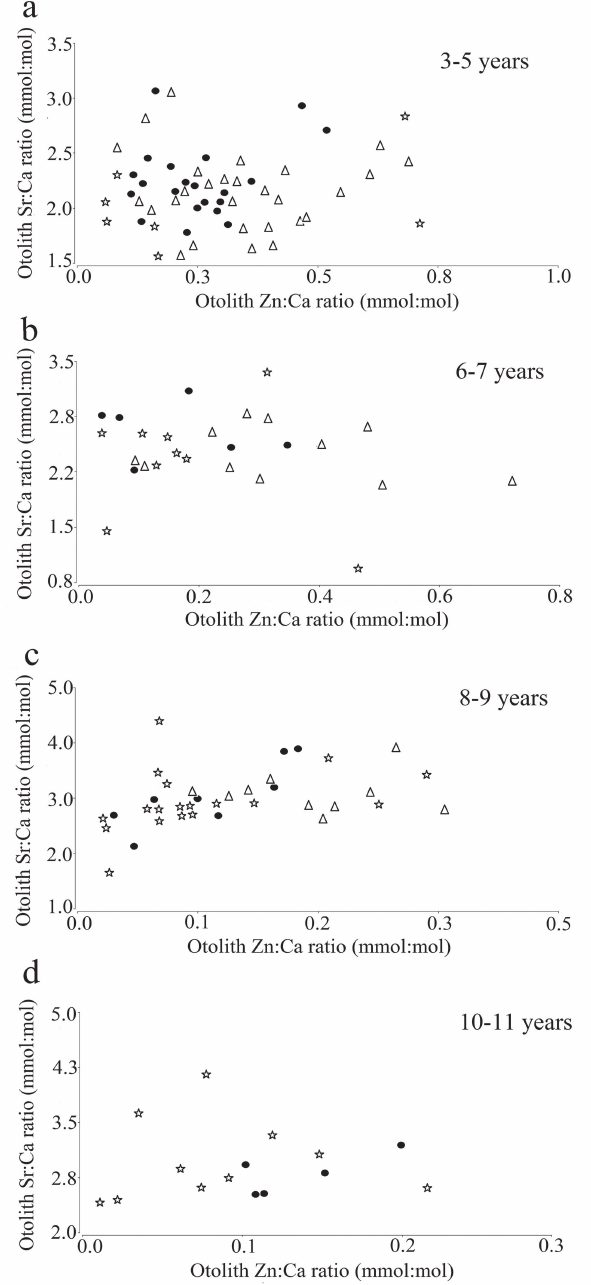
Fig. 3. Relationship between otolith Sr:Ca and Zn:Ca ratios (mmol mol -1 ) for Percophis brasiliensis from three areas. Data for ER and SMG tended to cluster, while data for AUCFZ tended to disperse. Separation of data of AUCFZ and ER-SMG is observed. Triangles: Argentine-Uruguayan Common Fishing Zone (AUCFZ), stars: San Matías Gulf (SMG) and black circles: El Rincón